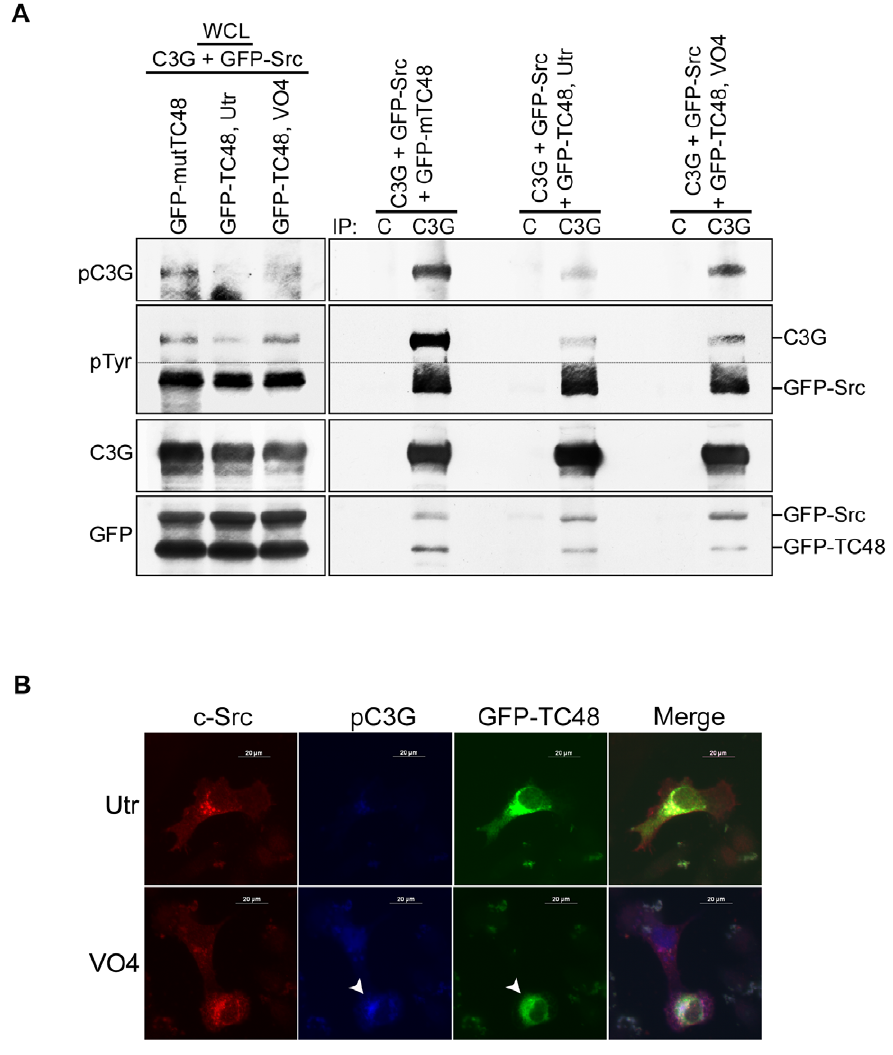
Figure 6. TC48 mediated C3G dephosphorylation is abrogated by vanadate. (A) C3G was immunoprecipitated from lysates of HEK293 cells expressing C3G and GFP-Src with either TC48 or mTC48. Immunoprecipitation in TC48 expressing cells was carried out in the presence (VO4) or absence (Utr) of sodium vanadate treatment. Along with lysates (WCL), the immunoprecipitates were subjected to Western blotting with the indicated antibodies. A dotted line has been added in the pTyr blot to indicate that probing for the blots corresponding to C3G and Src were carried out separately. C, control IgG. (B) IMR-32 cells expressing c-Src and GFP-TC48 were left untreated (Utr) or treated with vanadate (VO4) prior to fixation and staining for c-Src and pC3G. In the presence of vanadate, TC48 expressing cell (arrow) shows